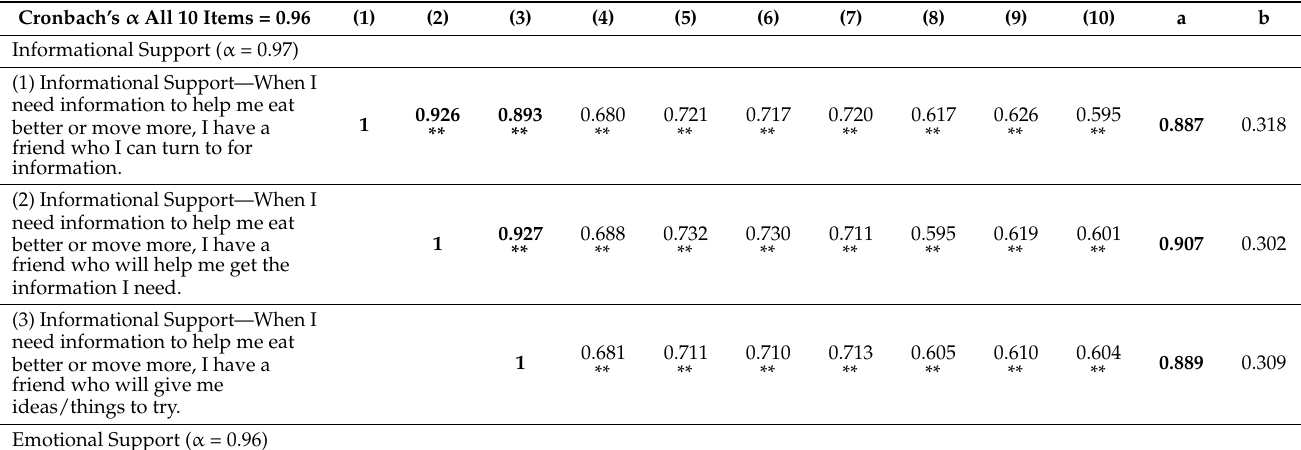
Table 3. Simple correlations within and between social support subdomain items (1) to (10) followed by varimax-rotated principal components analysis loadings (a) and